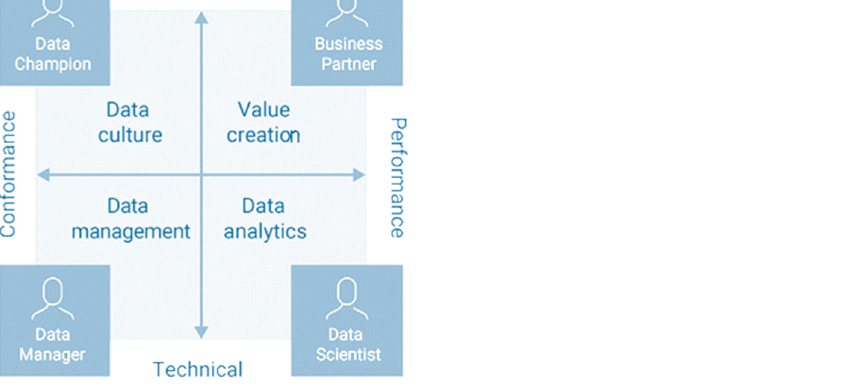
Figure 1. Possible roles in the era of Big Data and Business Analytics (CGMA 2014).